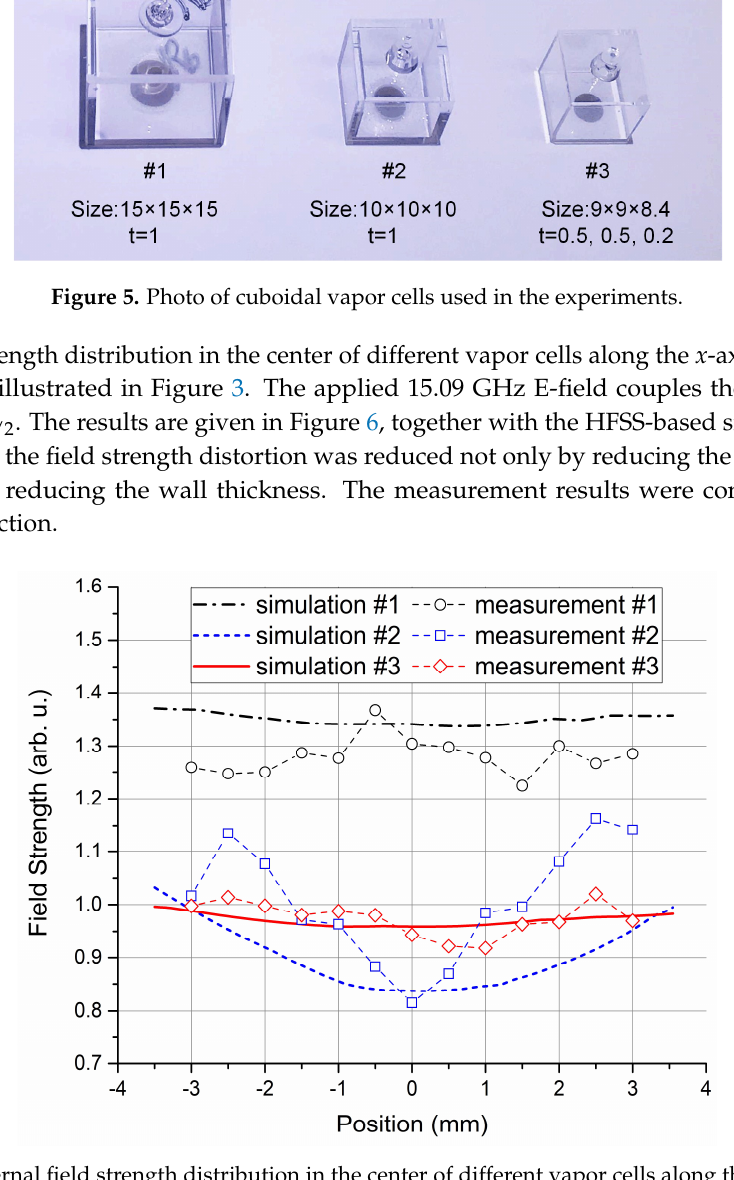
Figure 6. Internal field strength distribution in the center of different vapor cells along the x -axis with respect to different vapor cell geometries at 15.09 GHz. The results are compared in the overlapped range of these vapor cells, i.e., in a 7.0 mm segment.